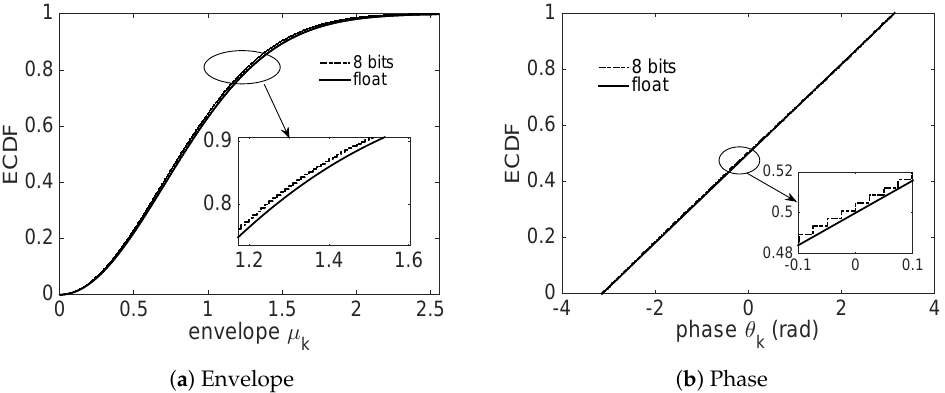
Figure 4. Empirical cumulative distribution function diagram of normalize complex Gauss random variable, in which solid line represents floating point operations, and dashed line represents 8-bit quantization